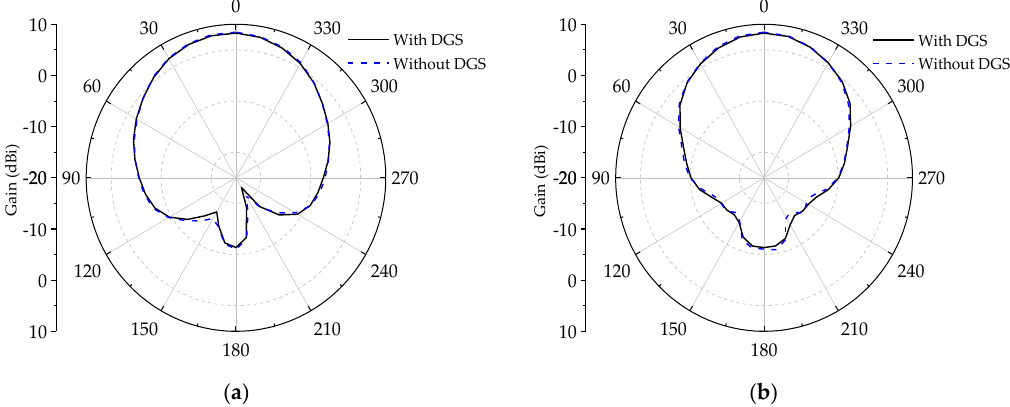
Figure 12. Operation frequency at 5.8 GHz. The radiation pattern of MIMO antenna with and without DGS. ( a ) E plane; ( b ) H